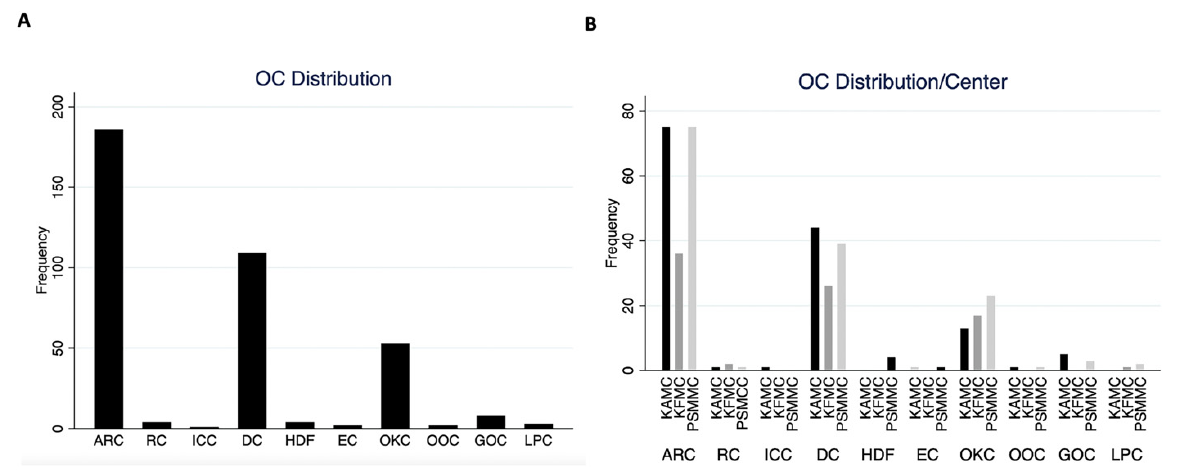
Figure 4. ( A ) Overall OC frequency in the current cohort. ( B ) OC frequency in each center.